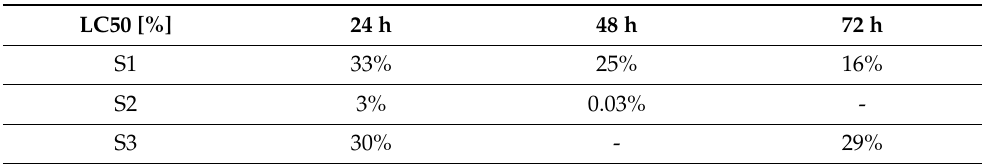
Table 7. The results of LC50 [%] for Algaltoxkit F for the studied surface water from sites S1 “Bł˛ekitna Laguna”, S2 “Huta”, and S3 “Mała